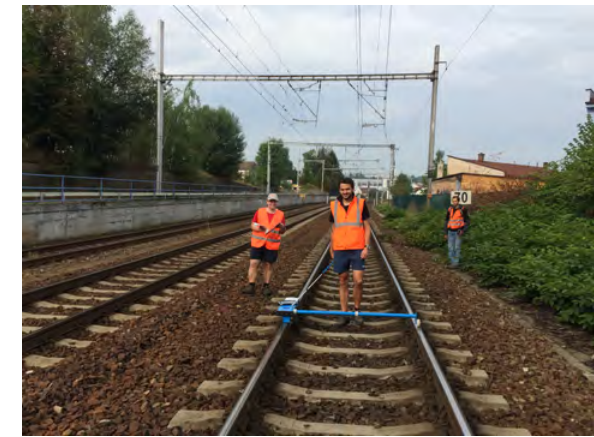
Figure 2. Investigation of rail corrugation by the Salamander device - Havlickuv